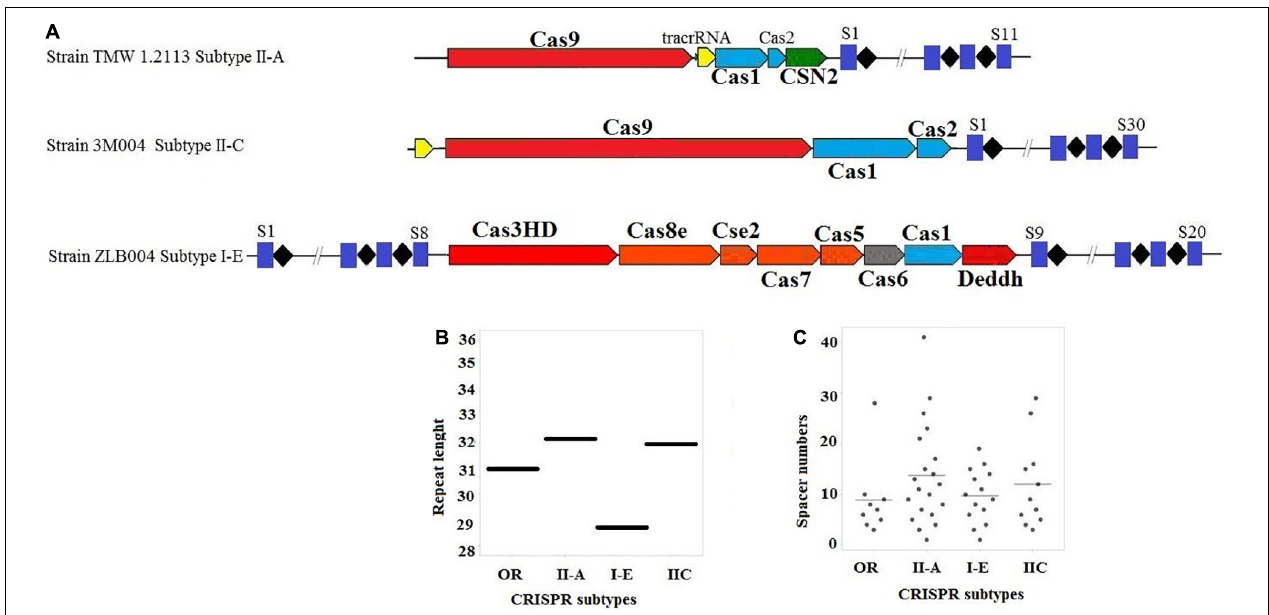
FIGURE 1 | (A) Schematic diagram of complete CRISPR-Cas array; (B) distribution of the repeat length, in nucleotides for each CRISPR-Cas subtype; (C) distribution of spacer numbers for each CRISPR-Cas subtype. Trans-activating CRISPR (tracr) RNA for subtype II systems is shown in